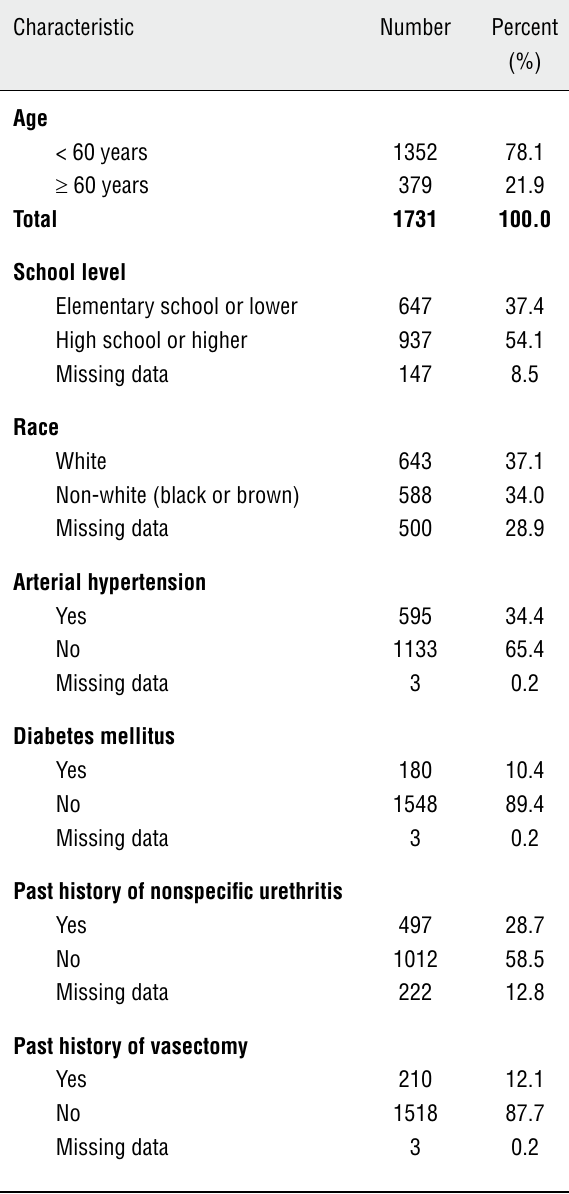
Table 1 - Demographic and clinical characteristics of study